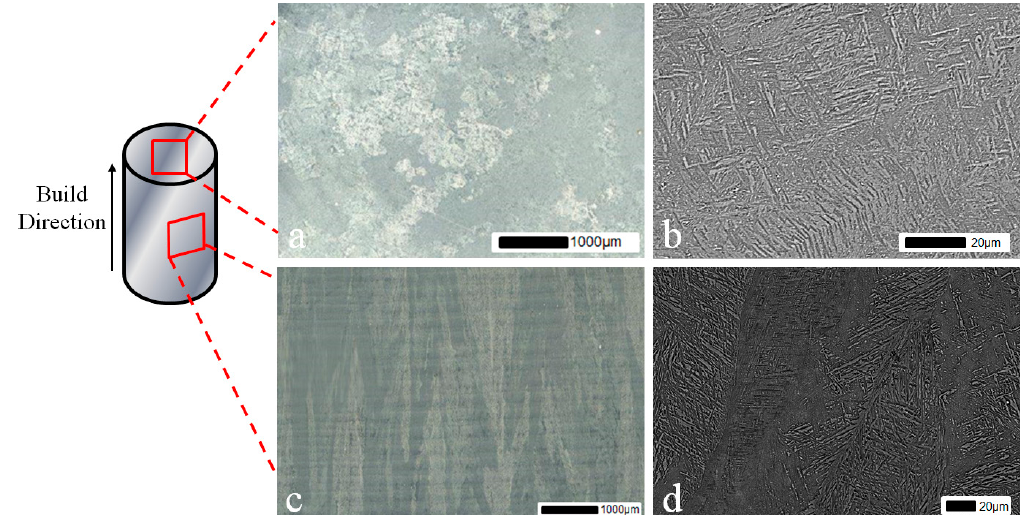
Figure 4. Microstructure of EBM Ti-6Al-4V ( a ) perpendicular to the build direction at low magnification; ( b ) perpendicular to the build direction at high magnification; ( c ) parallel to the build direction at low magnification and ( d ) parallel to the build direction at high magnification. Load is applied through the face perpendicular to the build direction. Table 1. Microstructural measurements of Ti-6Al-4V variants.